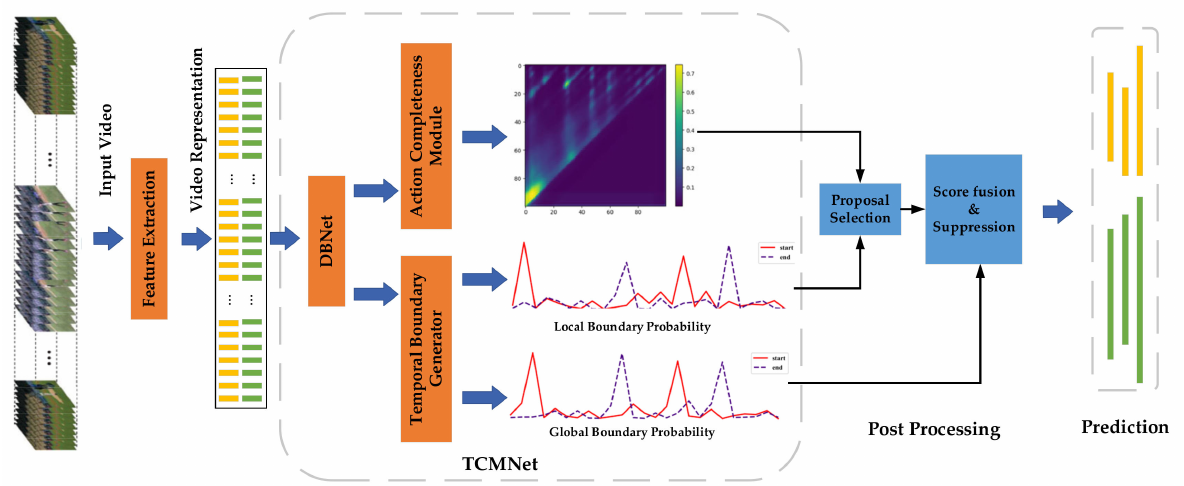
Figure 2. The framework of our method. TCMNet contains three main modules: BaseNet with dilated convolutions (DBNet) handles the extracted features for temporal relationship modeling. Action Completeness Module (ACM) evaluates the confidence of densely distributed proposals. Temporal Boundary Generator (TBG) generates high-recall and high-precision